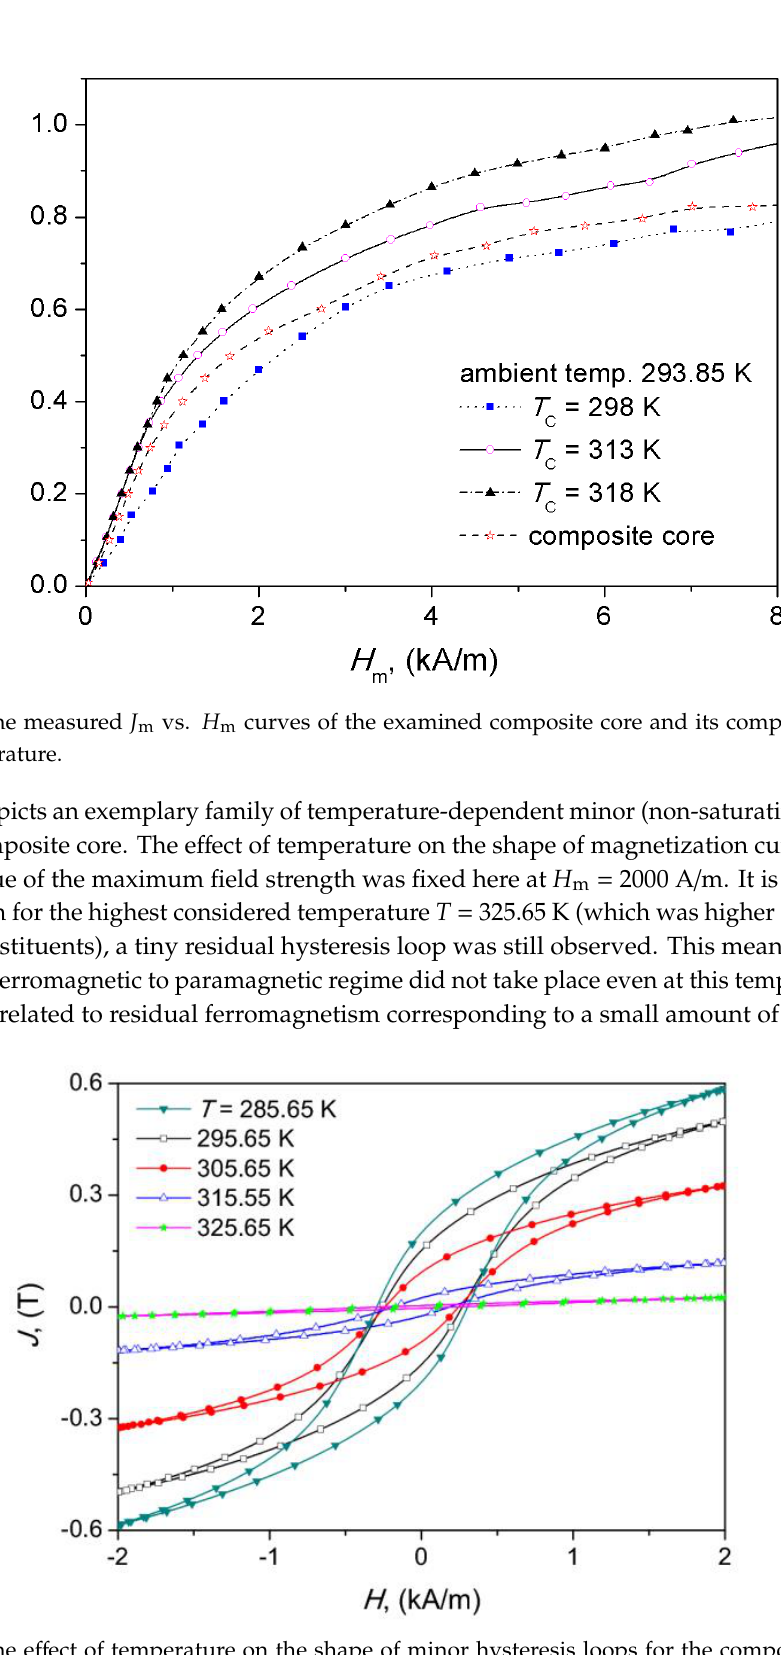
Figure 5. The measured J m vs. T dependencies for the examined composite core.